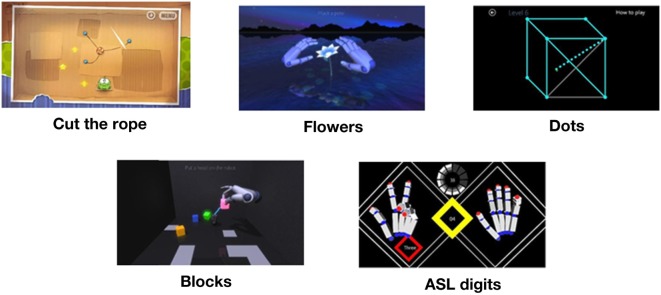
Games. Retrieved from Leap Motion App Store© (https://apps.leapmotion.com/?sign_up=true).